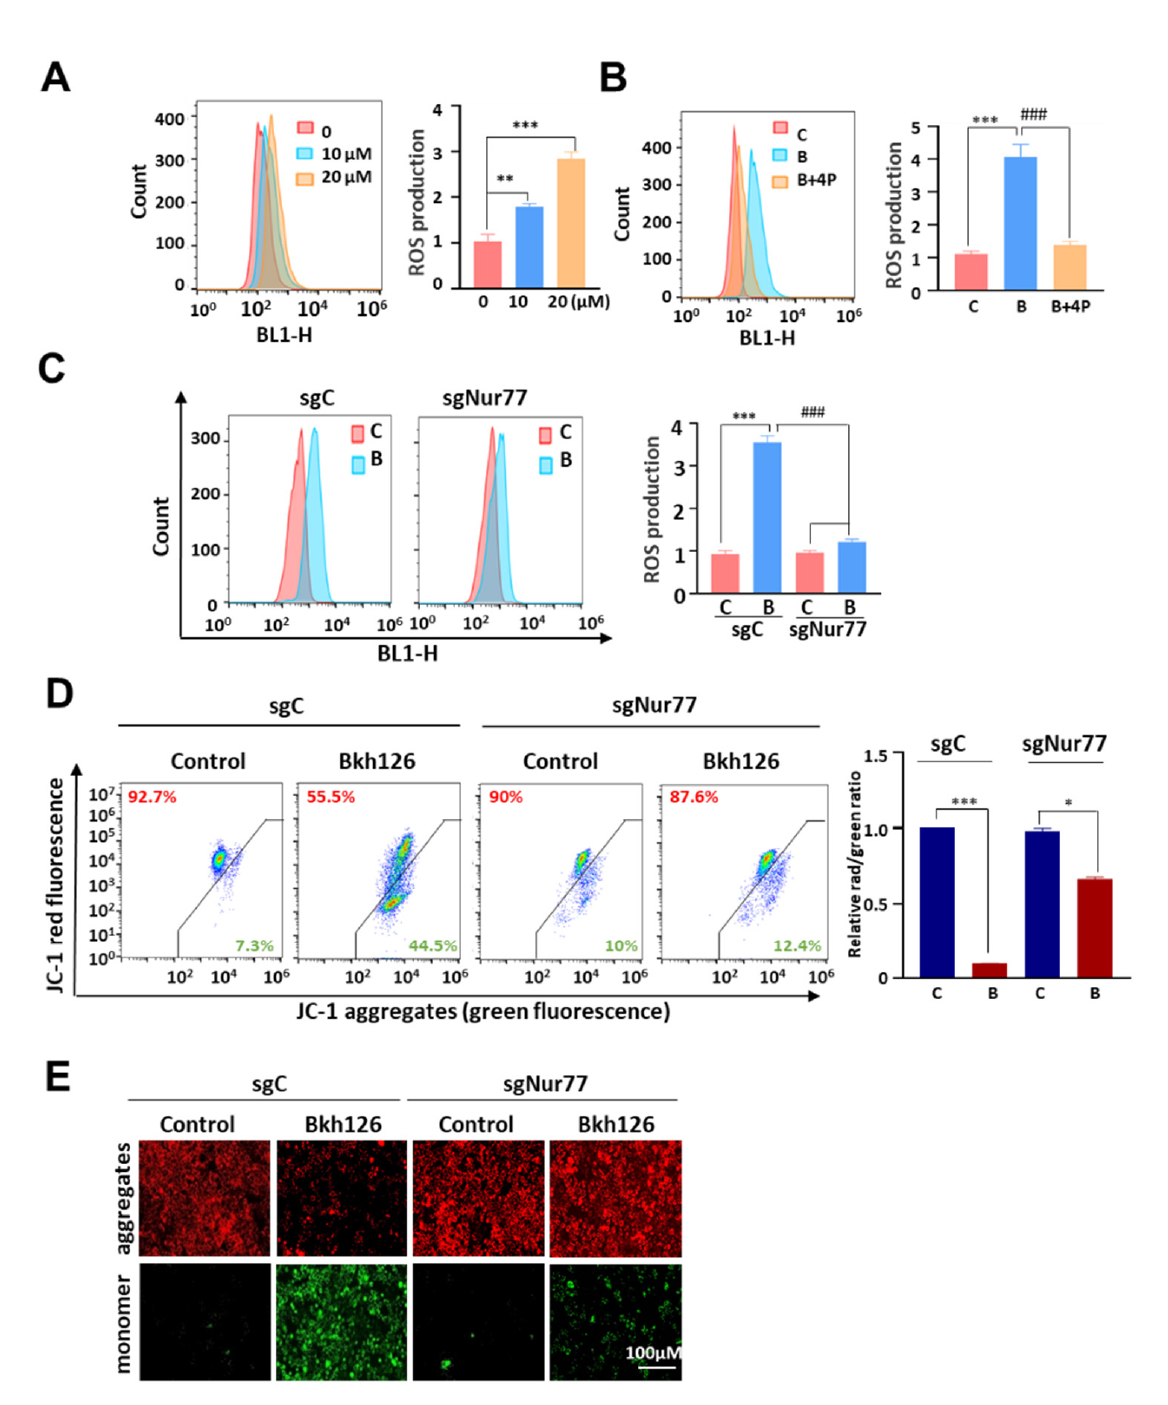
Figure 4. Bkh126 induces mitochondrial membrane potential dissipation : ( A , B ) ROS assays. HepG2 cells were treated with increasing concentrations of Bkh126 ( A ) or with 20 µ M Bkh126 combined with 4-PBA (ER stress inhibitor) ( B ) for 24 h. The cells were lysed and subjected to ROS analyses. ( C ) HepG2/sgC and HepG2/sgNur77 were treated with 20 µ M Bkh126 for 24 h. The cells were lysed and subjected to ROS analyses. ( D , E ) HepG2/sgC and HepG2/sgNur77 cells were treated with 20 µ M Bkh126 for 24 h. The cells were imaged with a fluorescent microscope ( C ) and analyzed with flow cytometry ( D ). * p < 0.05, ** p < 0.01, *** p < 0.001, and ### p < 0.001. C, control; B, Bkh126.